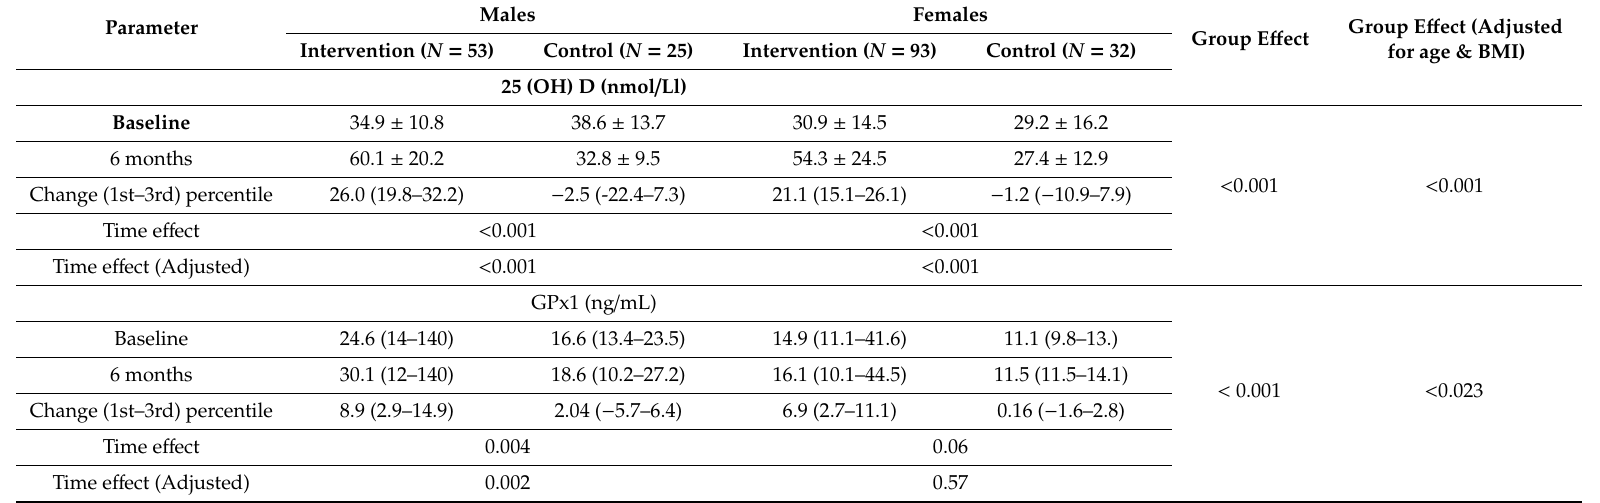
Table 2. 25(OH) D and GPX-1 at Baseline and After 6 Months of